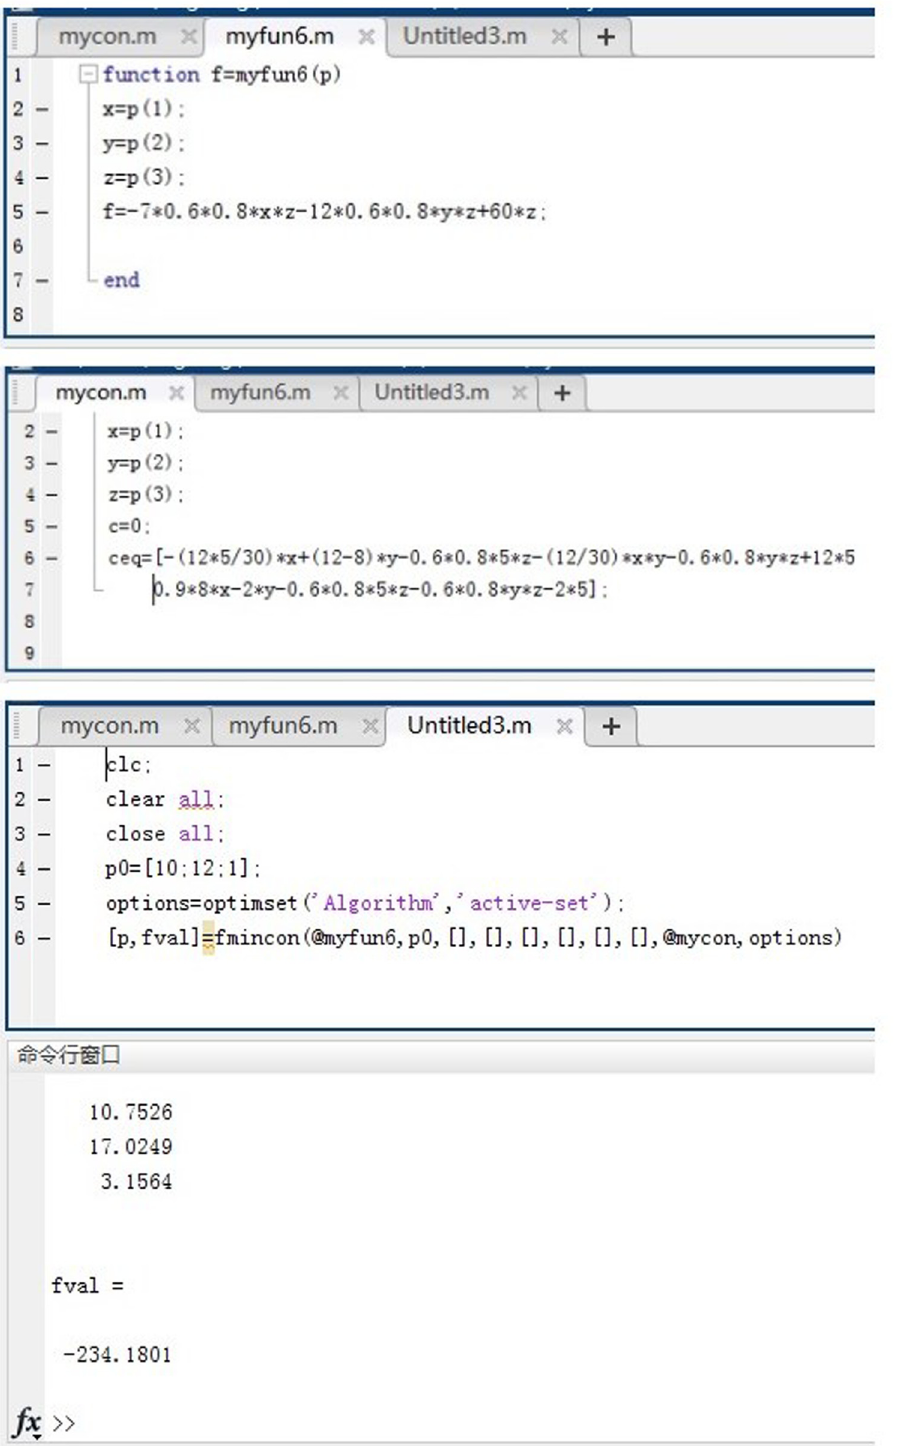
Figure 7: Optimal harvesting